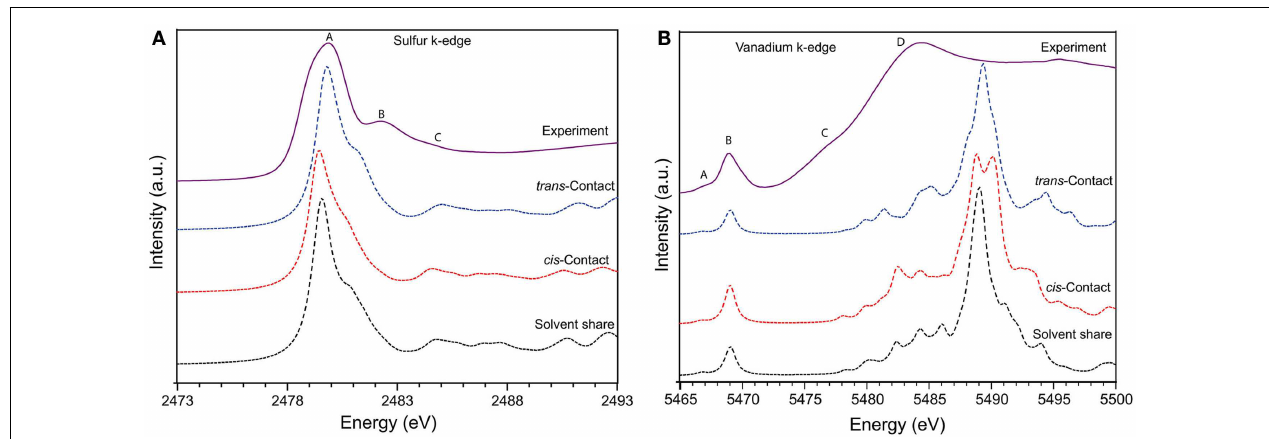
FIGURE 3 |The solid line represents experimental (A) sulfur K-edge and (B) vanadium K-edge X-ray absorption spectra of Nafion 115 membrane soaked in mixed-acid basedVO 2 + electrolyte solution . Dotted lines represent theoretically calculated spectra of three possible interaction mechanisms, namely, solvent share, contact pair through cis and trans position between solvated vanadyl ion with sulfonic acid sites inside the Nafion pores based onTDDFT XANES